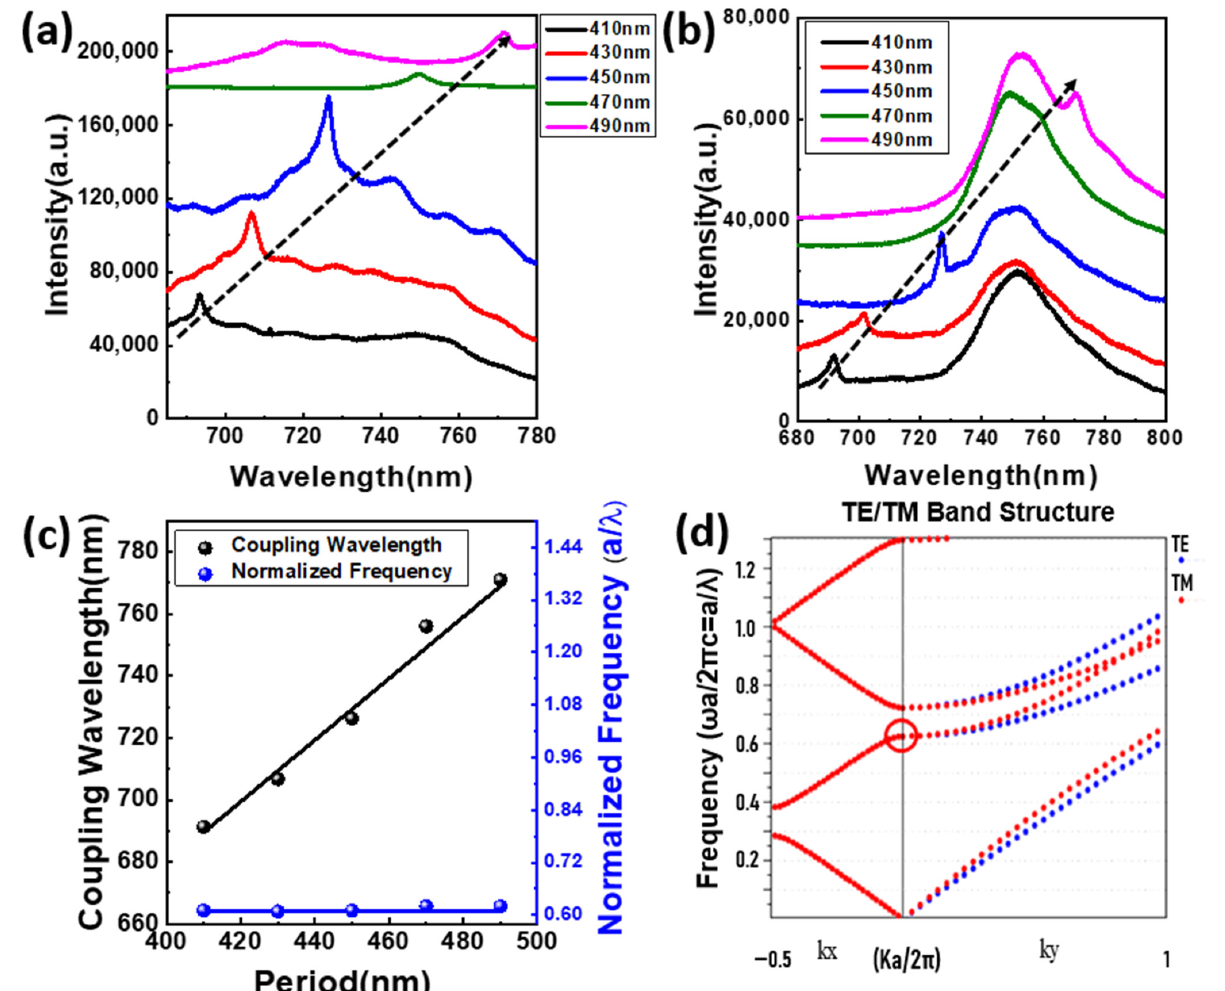
Figure 4. Coupling wavelength of the ( a ) 1-D PhC with different periods. ( b ) Integrated system with different lattice periods. ( c ) Coupling wavelength and normalized frequency with different lattice periods. ( d ) The 2-D PWE simulated TE-like band structure of the PhC.